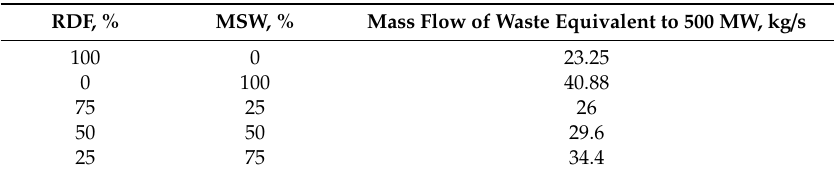
Table 3. Mass flow rate of waste (kg/s) required for a 500 MW polygeneration plant for different types and composition of wastes.